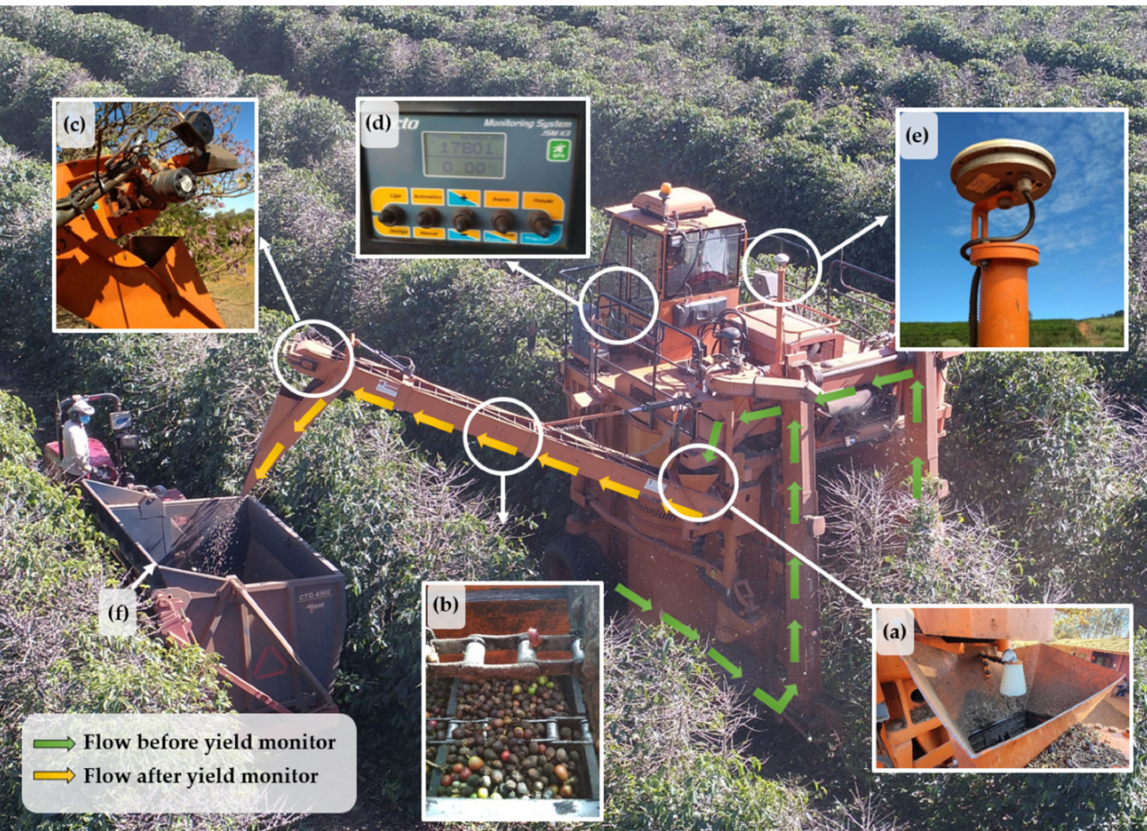
Figure 1. Flow of coffee fruits in the harvester and details of the components of the yield monitor, temporary reservoir, and ultrasonic sensor ( a ); paddle conveyor ( b ); hydraulic motor ( c ); data logger ( d ); GNSS receiver ( e ); coffee wagon ( f